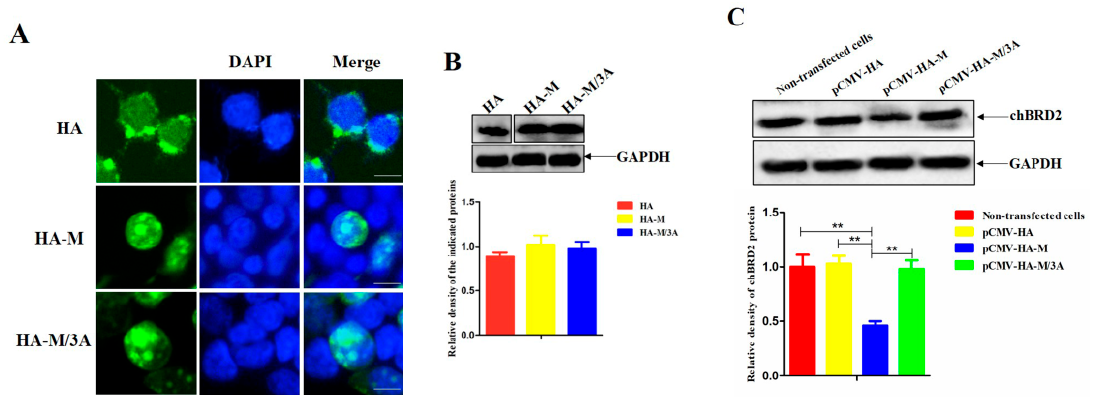
Figure 3. The M/3A protein abrogates the decreased expression of endogenic chBRD2. ( A ) The sub- cellular localization of M and M/3A proteins in plasmid-transfected cells. DAPI (blue) counterstained the nuclei. The original magnification was 1 × 100. Scale bars represent 10 µ m. ( B ) Detection of the expression of HA tag, HA-M, and HA-M/3A proteins by Western blotting. ( C ) The effect of HA tag, HA-M, or HA-M/3A expression on endogenic chBRD2 expression. Asterisk denotes significant difference (**, p < 0.01).